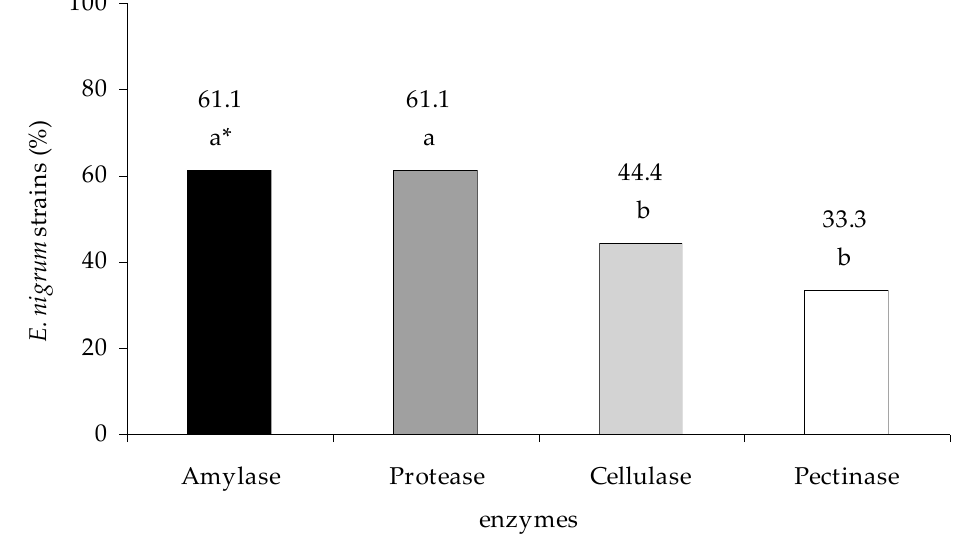
Figure 5. The percentage of E. nigrum strains among the 18 tested synthesizing a given enzyme. Means followed by the same letter (*) are not statistically different at the α ≤ 0.01 level according to the Tukey HSD test.